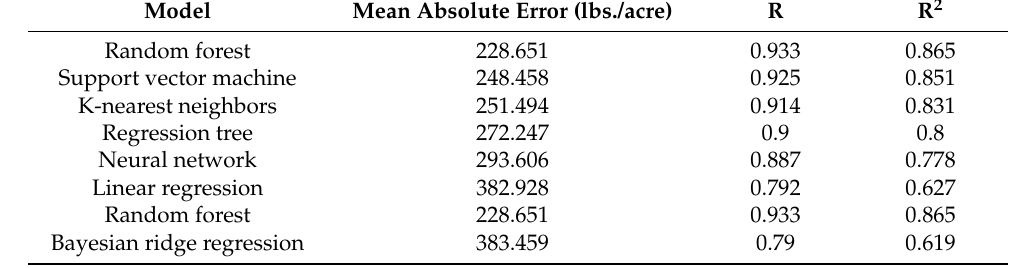
Figure 3. Results from Cfs feature selection with all features. The results from linear regression and Bayesian ridge regression were much lower than the other models, so their results are not shown here. The results are shown explicitly in Table 4.